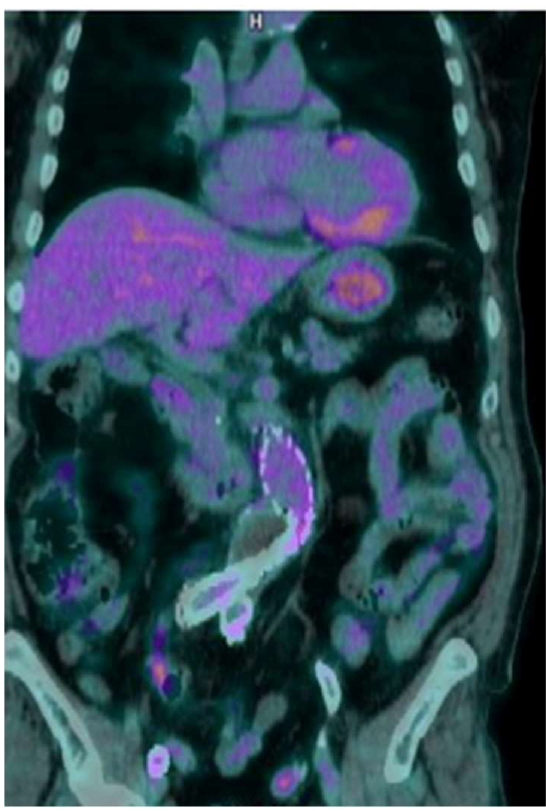
Figure 4. Coronal view of a negative [ 18 F]FDG PET/CT, showing mild and diffuse [ 18 F]FDG uptake along the graft.